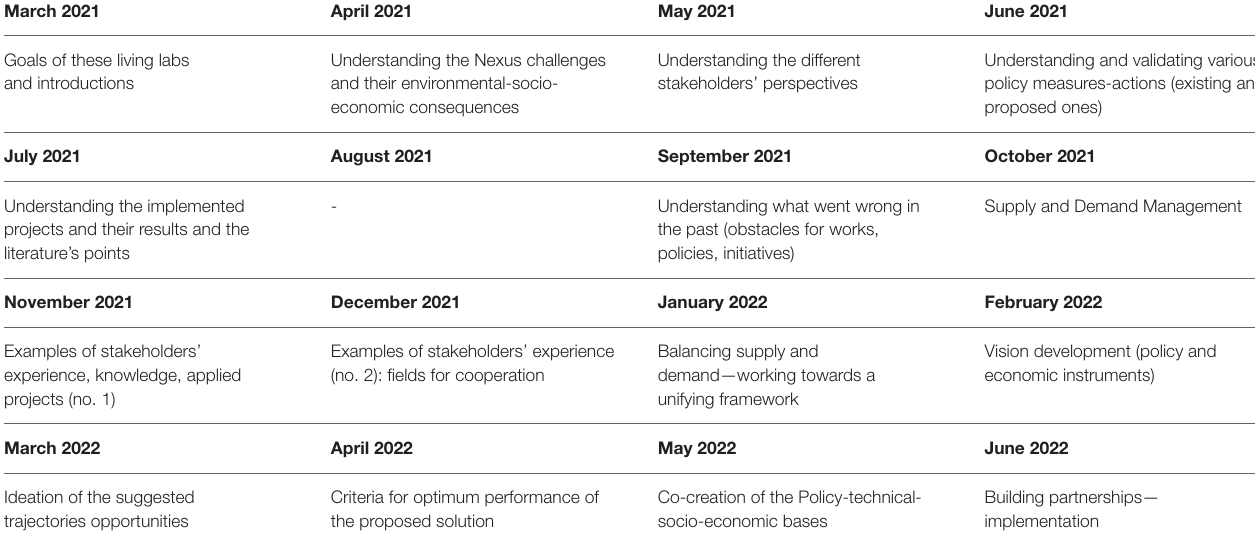
TABLE 2 | Timeline of the Living Labs and workshop